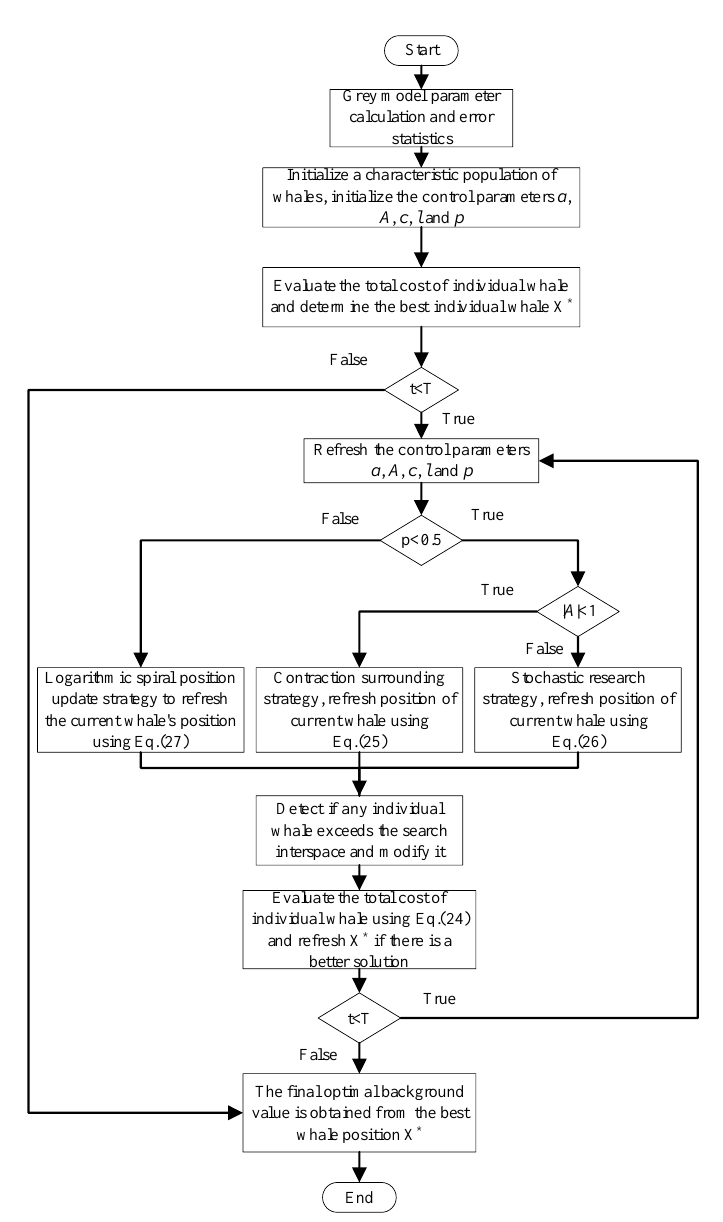
Figure 7. Flow chart of background value optimization.